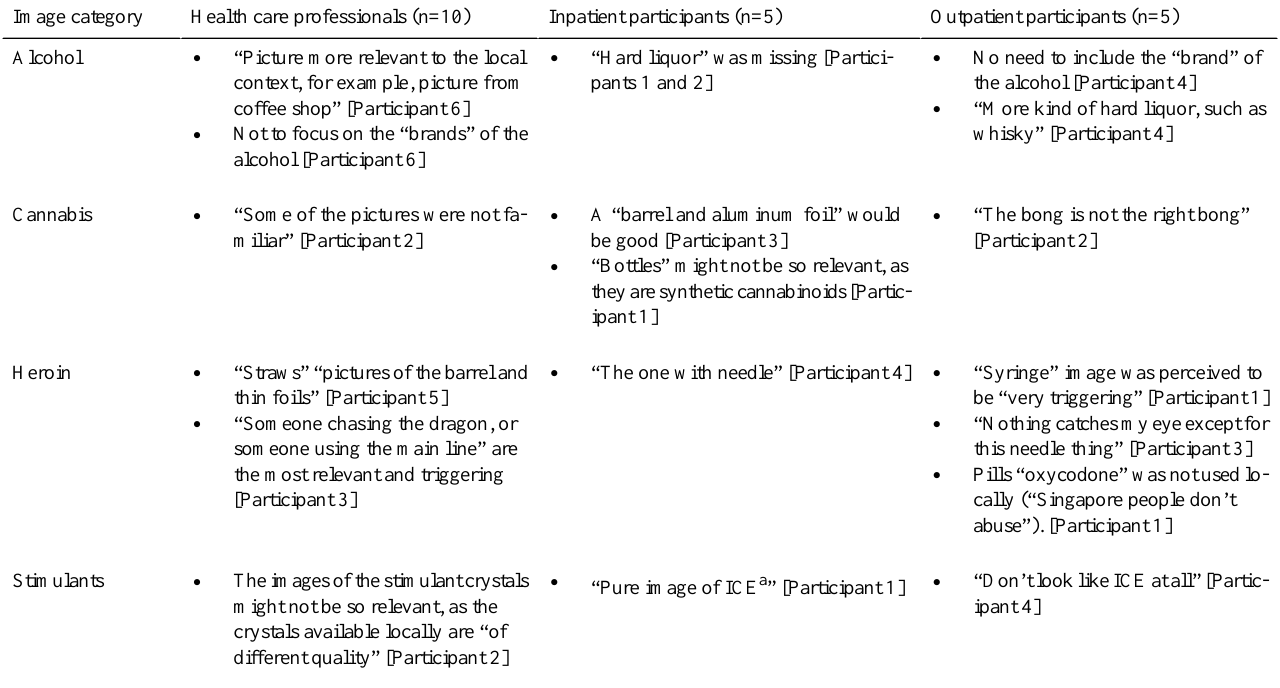
Table 6. Suggestions of participants for images included in the